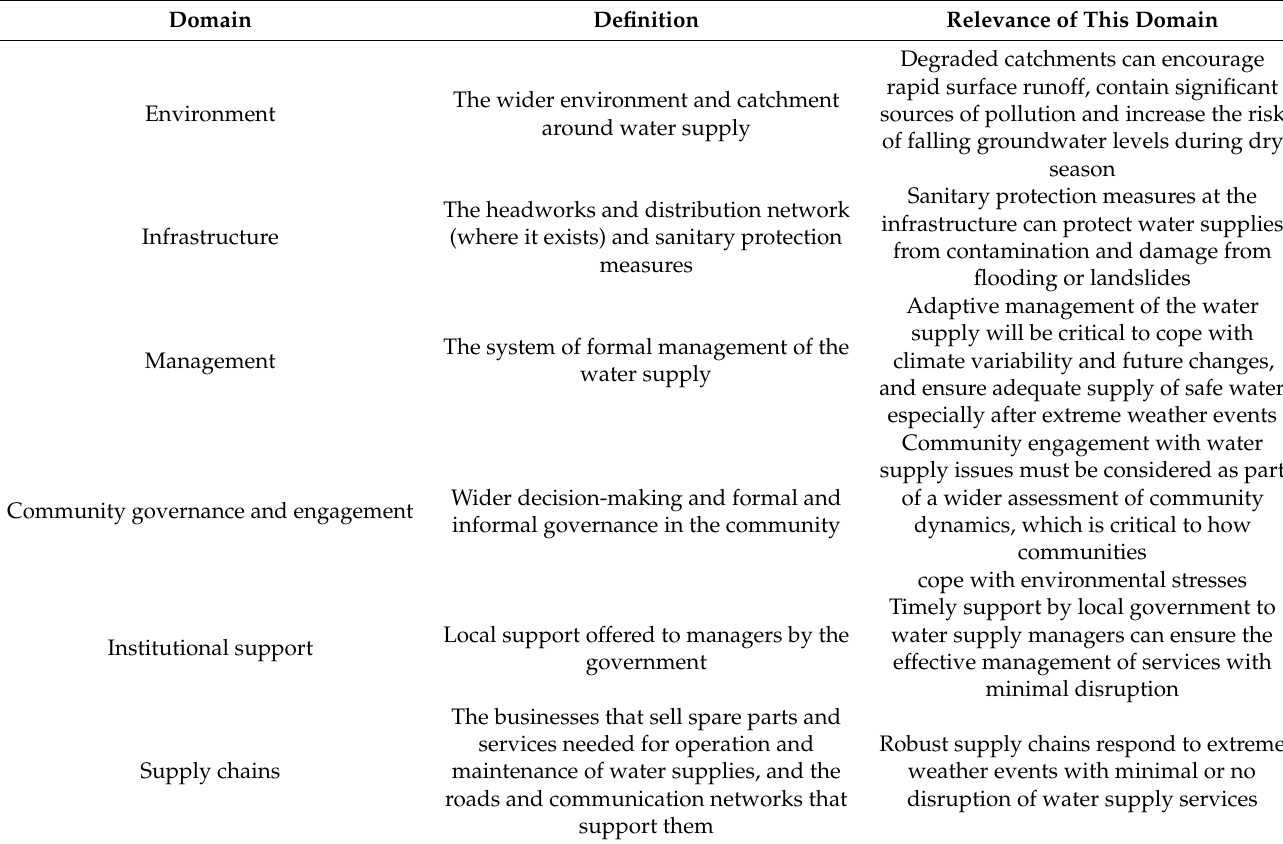
Table 1. The domains of resilience in the How Tough is WASH framework